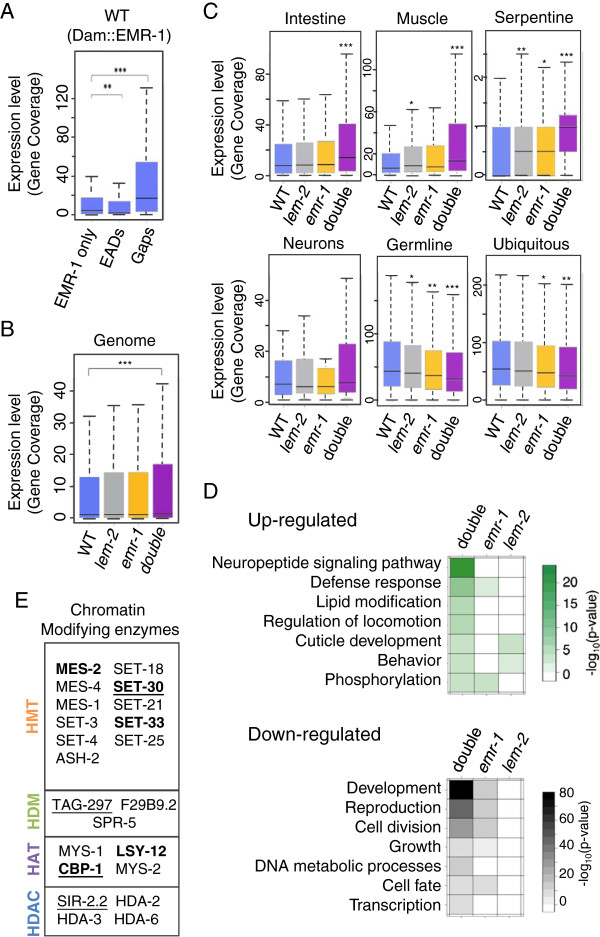
Mutations in emr-1 and lem-2 de-repress gene expression. (A) Boxplot (as in Figure 1) of expression levels of genes included in ‘EMR-1 only’ elements, EADs or gaps. Gene expression is measured as the median coverage of exons per gene. (B) Comparison of the expression of all genes in wild type (WT), lem-2(tm1582), emr-1(gk119) and emr-1(RNAi) lem-2(tm1582) ('double') animals. (C) Expression of tissue-specific genes grouped as described in Figure 3. *P < 10-2, **P < 10-4 and ***P < 10-11. (D) Gene Ontology analysis of genes up- (green) or down-regulated (black) in lem-2(tm1582), emr-1(gk119) and emr-1(RNAi) lem-2(tm1582) animals compared to wild type (P < 0.01). (E) Chromatin modifying enzymes with altered expression in emr-1(RNAi) lem-2(tm1582) nematodes. Most genes are down-regulated, except underlined genes, which are up-regulated. Genes also affected in the emr-1(gk119) single mutant are shown in bold.